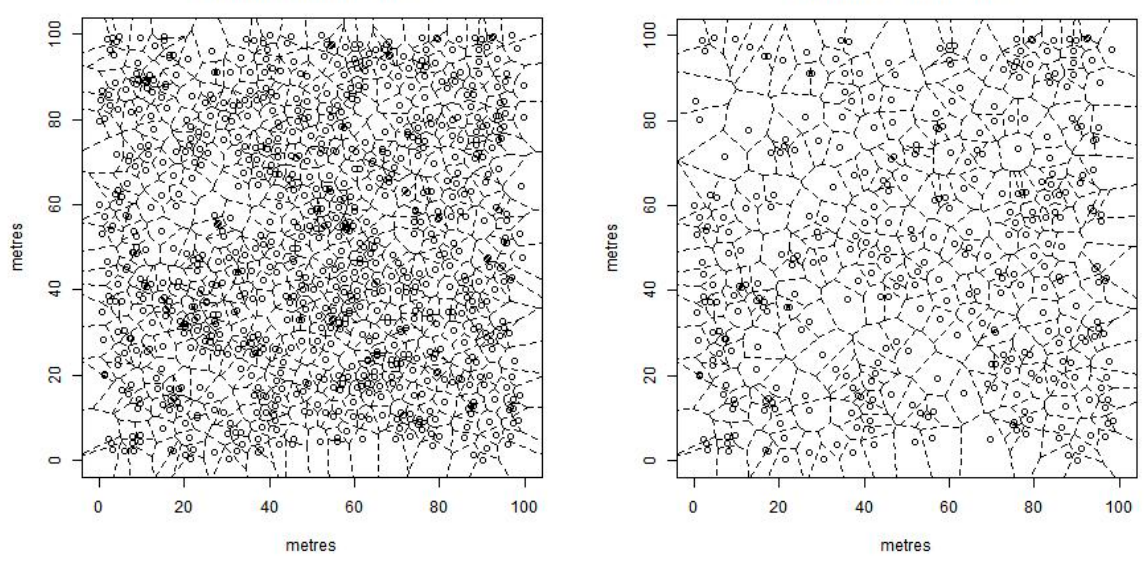
Figure 11. Voronoi tile plots of all live trees (all species) in the Buck Mountain plot at plot establish- ment (Buck Mountain Time 1) and the 2013 assessment (Buck Mountain Time 2). Table 8. Empty space radial distances measured for live healthy trees, all species, at time of plot establishment (Time 1) and at most recent assessment (Time 2) for the 11 plots combined. Bins open on the left side. Average bin size and frequency as % of total bin counts. The range of years between Times 1 and 2 was 7–15.